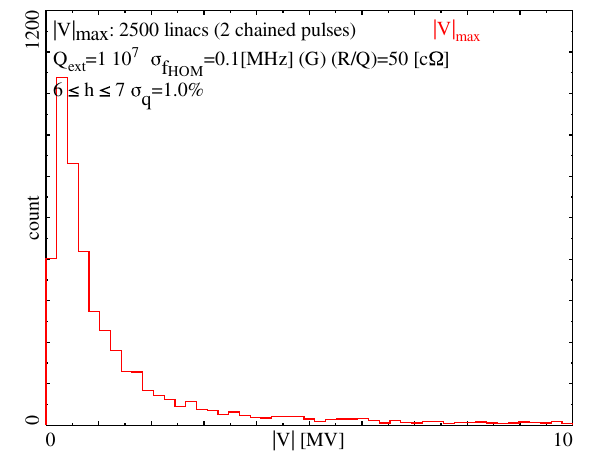
FIG. 27. (Color) dE as a function of (cid:1) (cid:3) f for two consecutive pulses with Q ext ¼ 10 8 , I b ¼ 400 mA ; red: worst bunch in pulse; blue: rms; filled upward triangles: with 1% charge scatter; hollow downward triangles: without bunch noise.